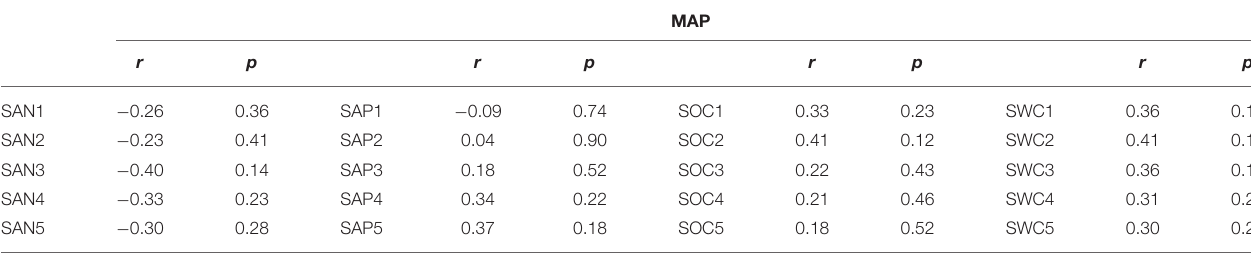
TABLE 3 | Soil nutrients show no significant relationship with mean annual precipitation.